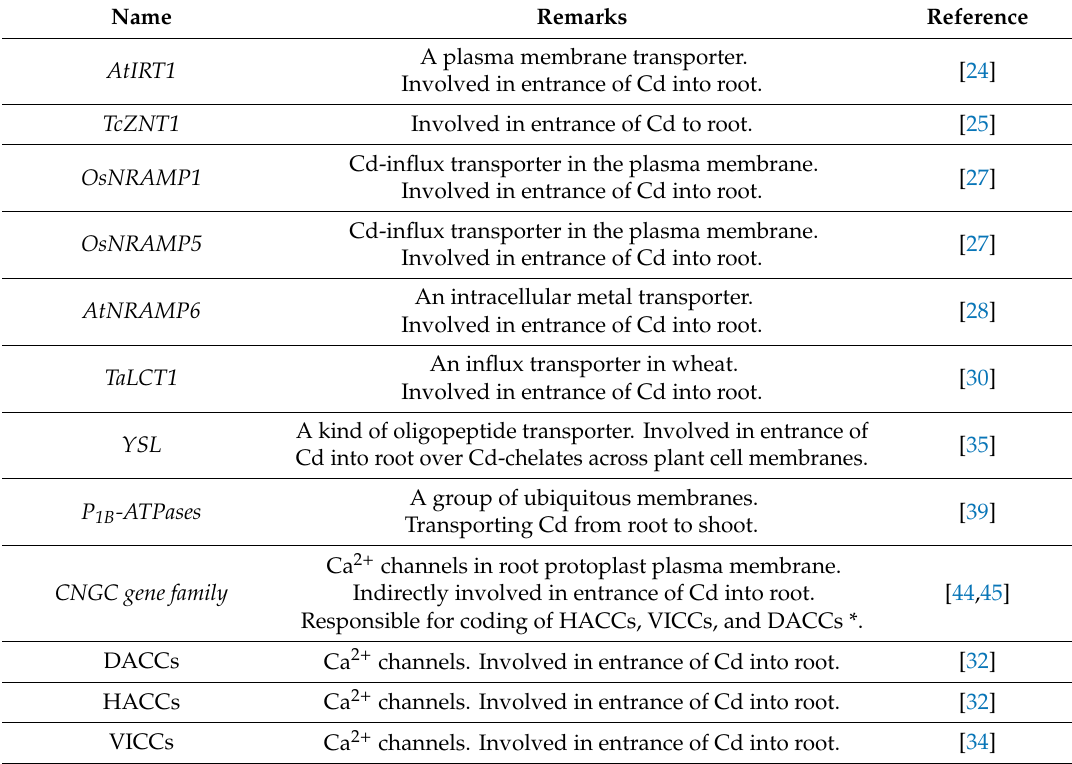
Table 2. Gene families and channels involved in the Cd uptake, transport, and metabolism in